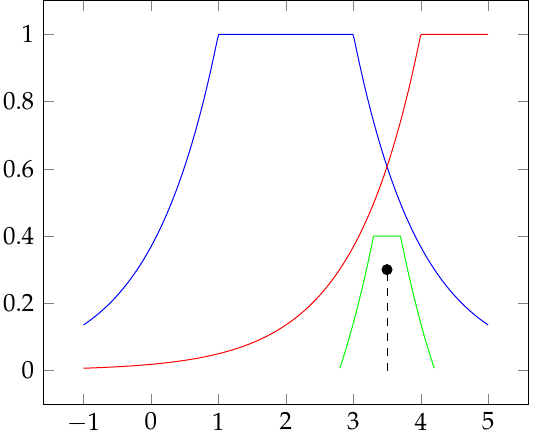
Figure 3. A figure demonstrates that for two fuzzy sets B 2,1 and B 5,1 and a point x a , where x = 3.5 and a = 0.3, from the intersection, we cannot find a ball B x X = IR, E is the fuzzy equivalence relation with respect to the product